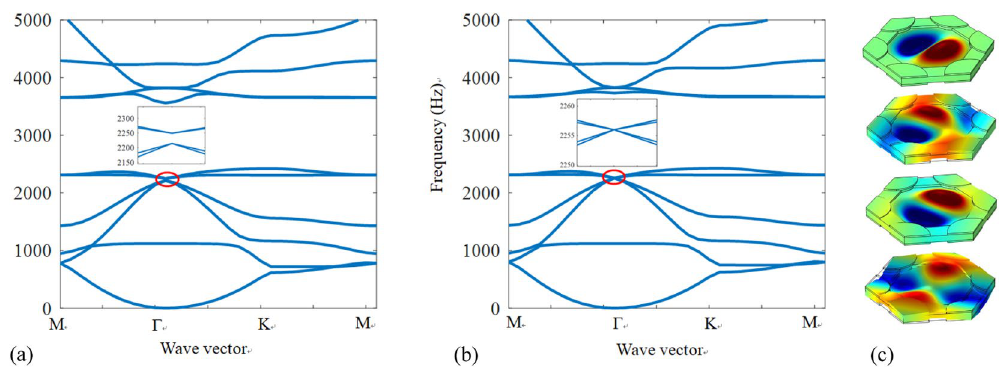
Figure 2. ( a ) Band gap, ( b ) the Dirac point induced by the electric circuit and ( c ) its displacement fields of the four degenerate states at the Dirac